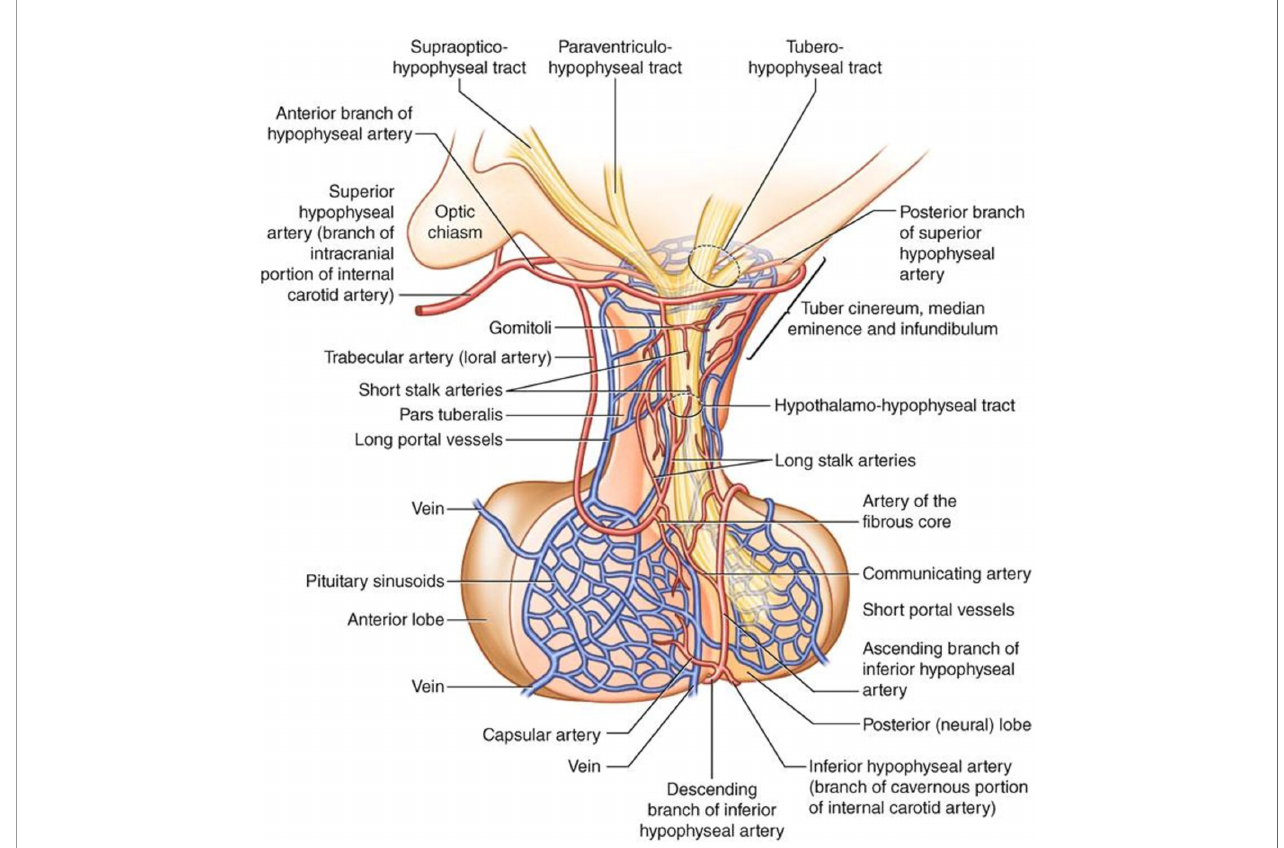
FIGURE 2 | Anatomy and vascularization of the hypothalamus and pituitary gland [reproduced with permission from (51)].